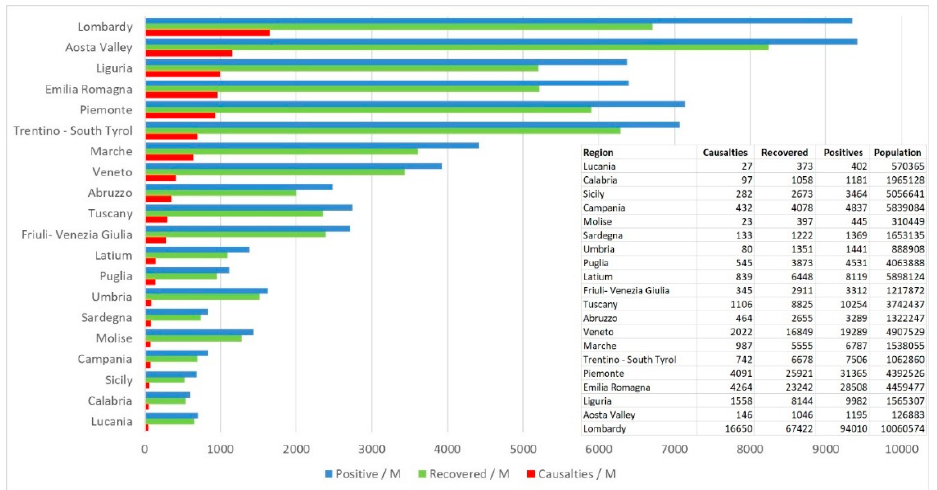
Figure 1. Regional distribution of coronavirus disease 2019 (COVID-19) on 1 July: Data per million population (source: National Civic Protection).